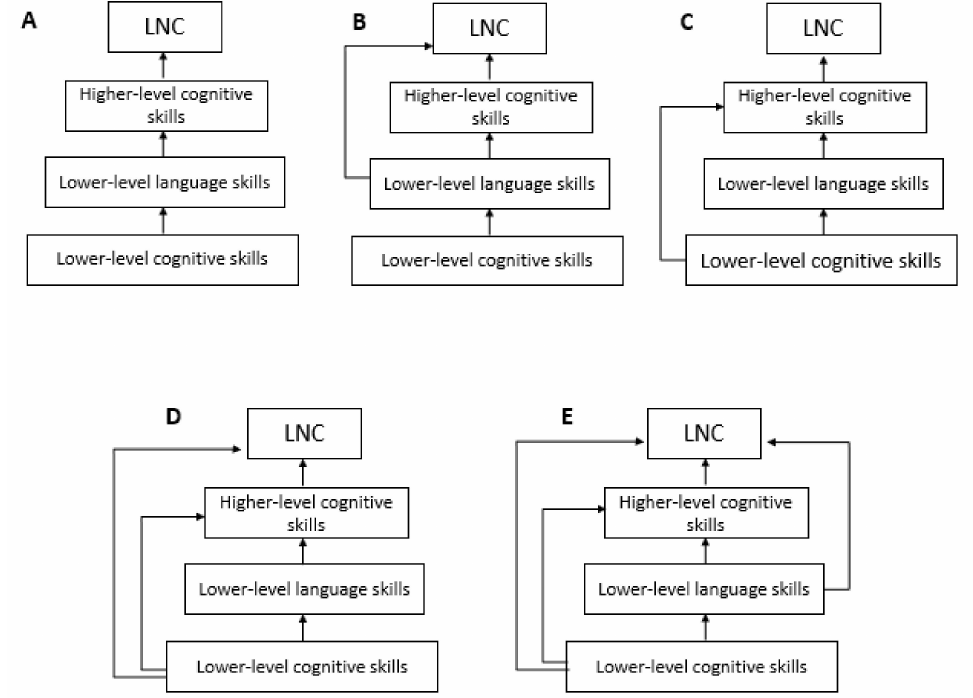
Figure 1. Five alternative models of hypothesized relations of cognitive and language skills to listening narrative comprehension. Panels ( A – E ) represent Models 1, 2, 3, 4, and 5, respectively. Note: LNC = Listening Narrative comprehension; higher-level cognitive skills = inferences, ToM and knowledge of story-structure; lower-level language skills = vocabulary, syntactic knowledge, and rapid naming; lower-level cognitive skills = WM, inhibitory control and attention